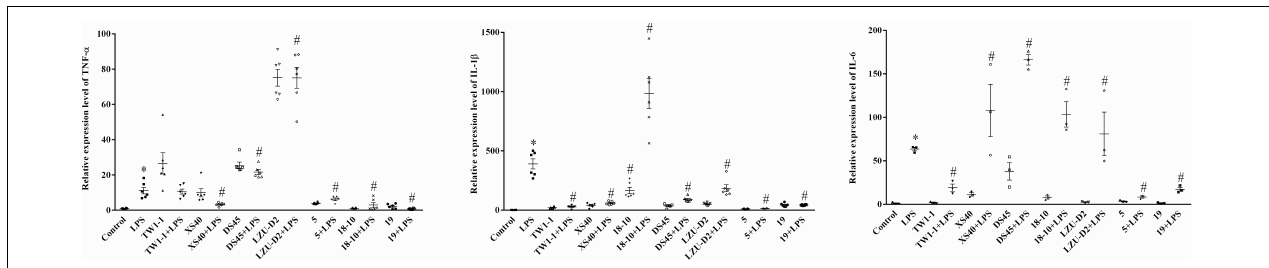
FIGURE 1 | The expression of inflammatory factors (IL-1 β , TNF- α , and IL-6) in LPS-treated, strains-LPS treated, and untreated RAW264.7 cells ( n = 3). Error bars represents SEM. ∗ P < 0.05, Compared with control group. # P < 0.05, Compared with LPS group.